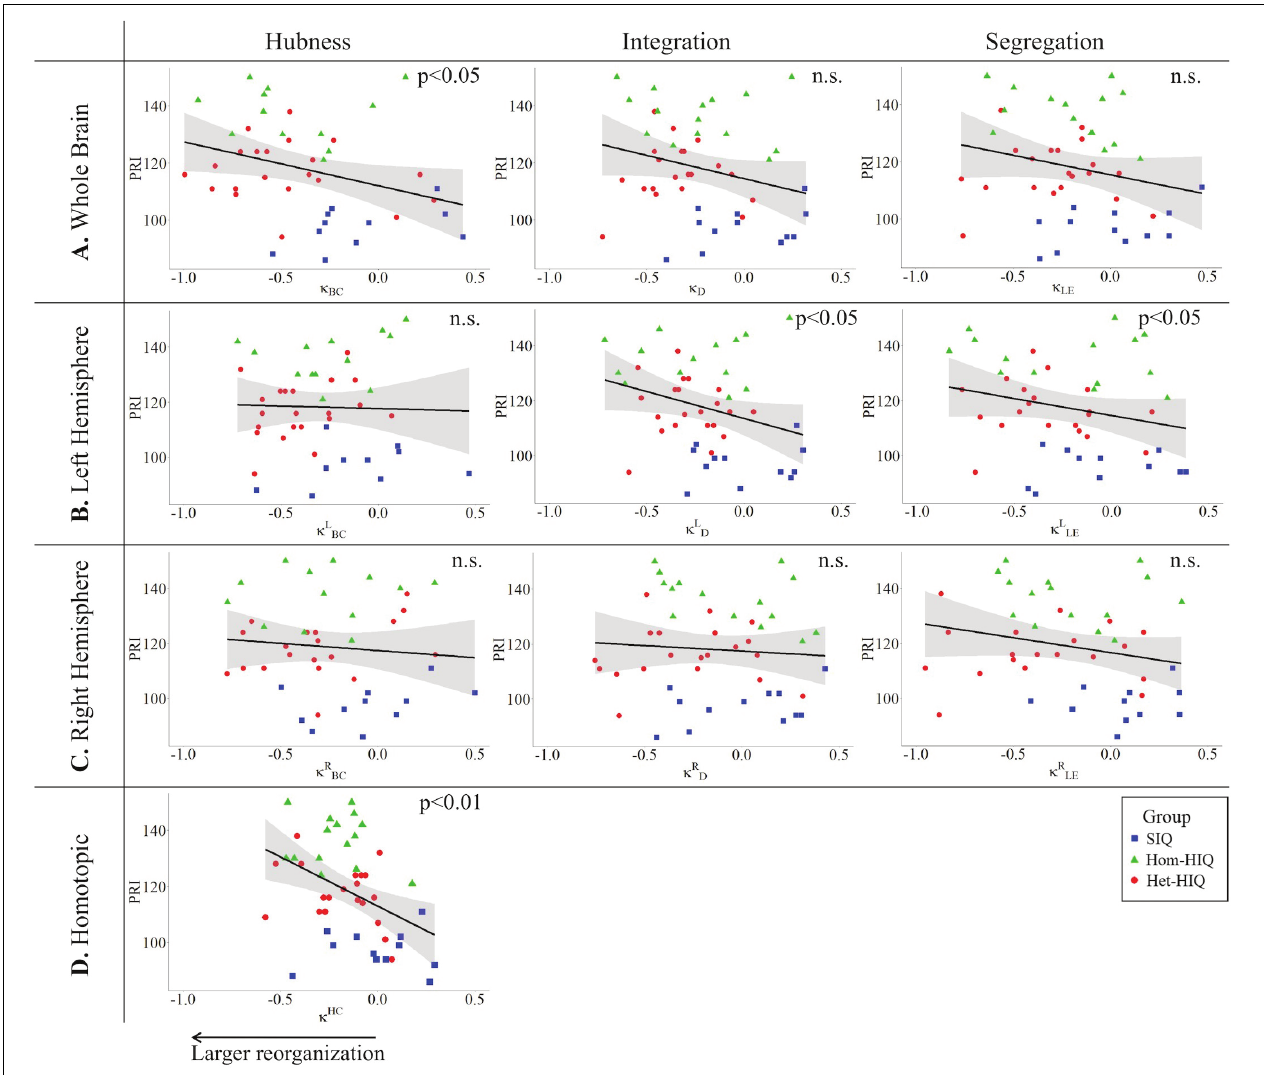
FIGURE 4 | Correlations between perceptual reasoning index (PRI) and hub disruption indices ( κ ) of graph metrics measured in: (A) the whole brain networks, (B) the left hemispheric networks, (C) the right hemispheric networks, and (D) the homotopical nodes. Significant correlations were measured for κ describing hubs properties in the whole brain networks ( κ BC ), for integration ( κ L D ) and segregation properties in the left hemisphere ( κ L LE ), and for homotopic connectivity ( κ HC